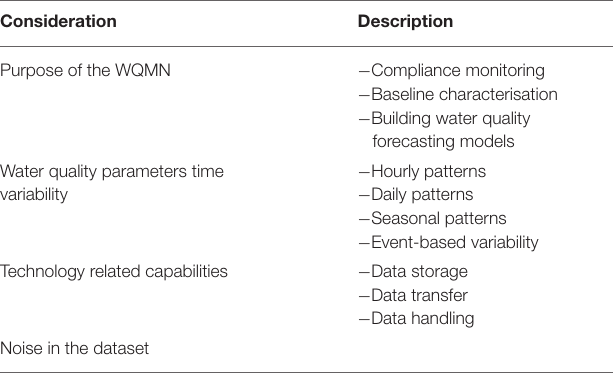
TABLE 1 | Considerations to address when defining the sampling frequency for a high frequency